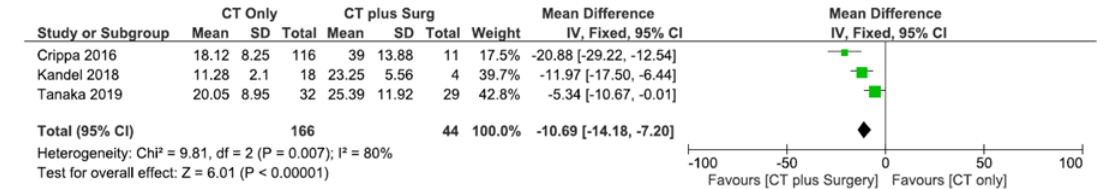
Figure 2. Forest plot of survival analysis.